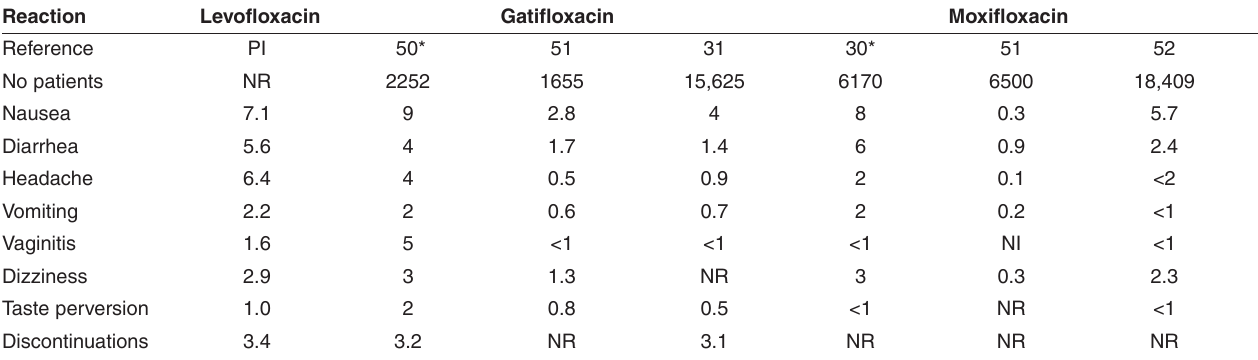
TABLE 6 Comparison of adverse drug reactions associated with some approved fluoroquinolones (%)